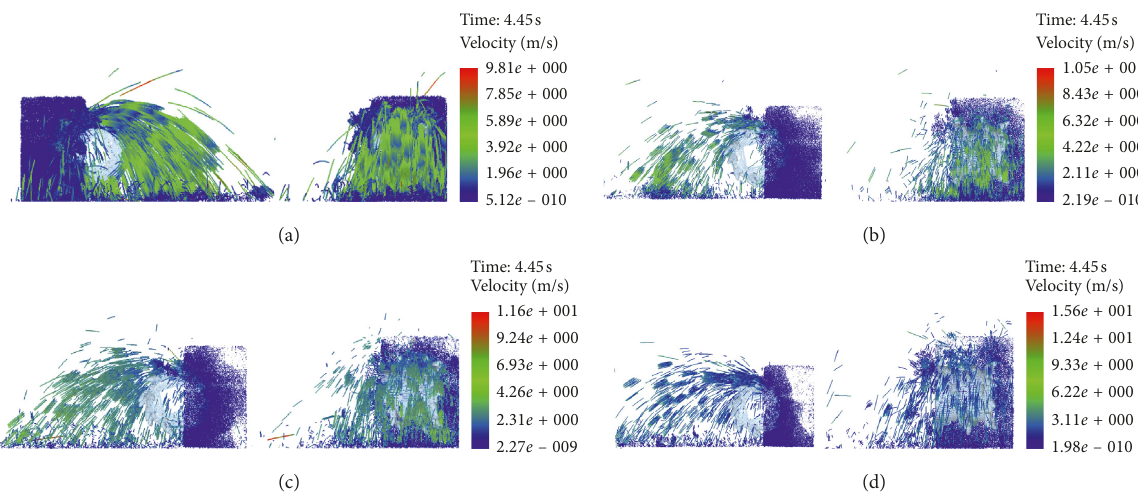
Figure 7: Velocity of the coal particles. (a) n